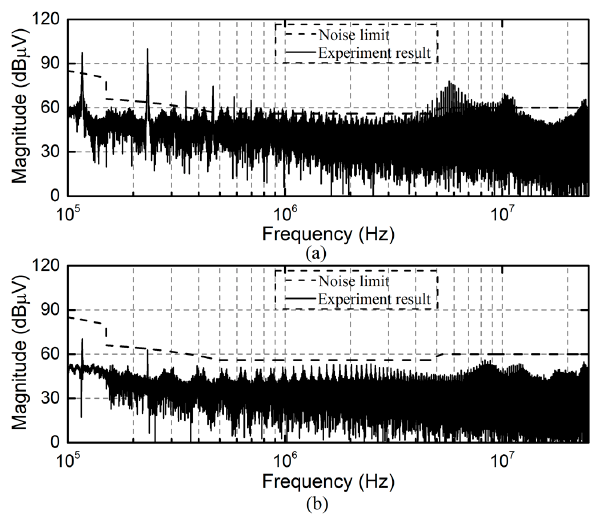
Figure 12. DM EMI noise, ( a ) without the EMI filter, and ( b ) with the EMI filter. Table 2. THD analysis results.